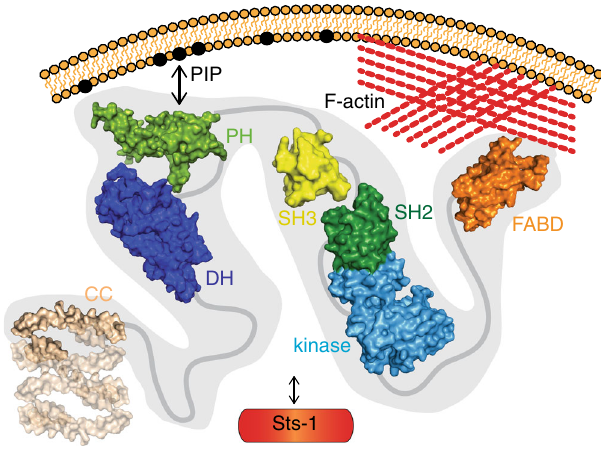
Fig. 7 Model of the structural organization of Bcr-Abl p210 and contributions to cellular localization and signaling. Domain CC coiled-coil, DH Dbl-homology, PH Pleckstrin-homology, SH3/SH2 Src-homology 3/2, FABD F-actin binding domain. High-resolution structures of the individual domains were solved in this study (DH: PDB ID 5NR6, PH: PDB ID 5OC7) and in previous studies (CC: PDB ID 1K1F, SH3: PDB ID 1OPK, SH2-Kinase: PDB ID 1OPL chain B, FABD: